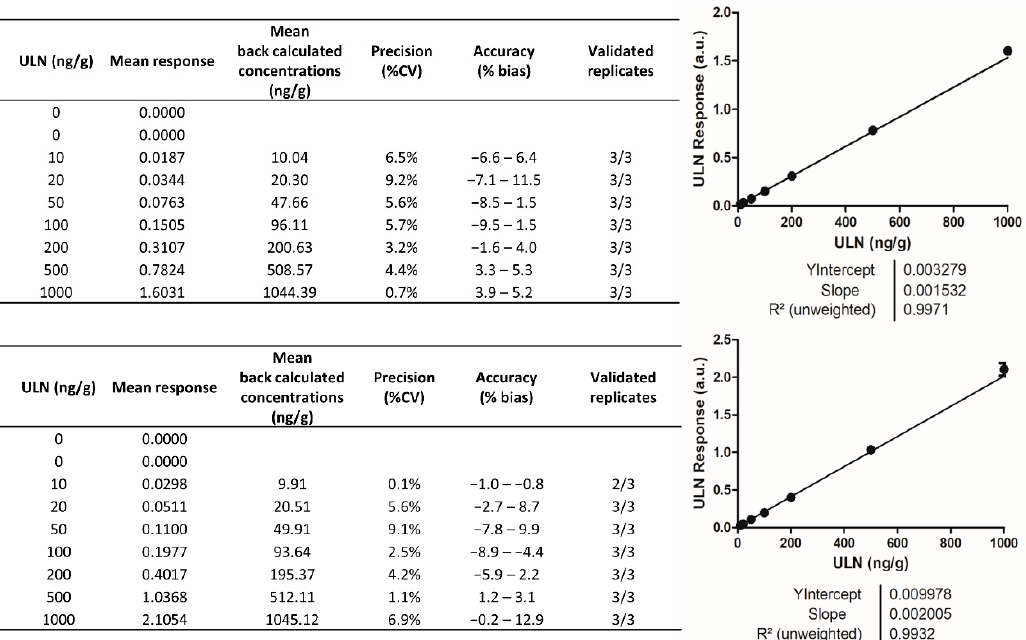
Figure 5. Analytical batches using triplicate analyses of calibration points. Accuracy and precision data with calibration curves obtained for ( A ) first batch and ( B ) second batch.